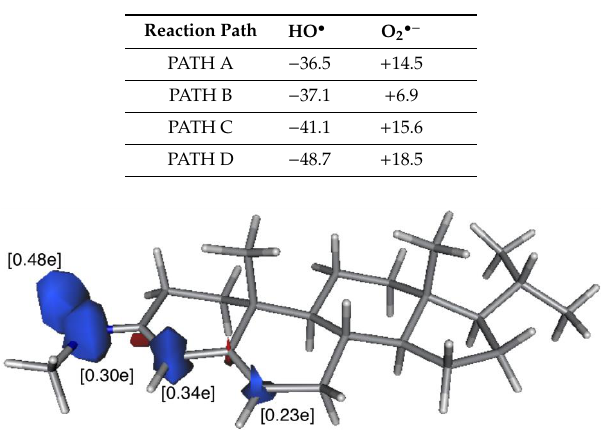
Figure 1. Computed spin density (isovalue = 0.01 au) for compound 4 of Scheme 1.